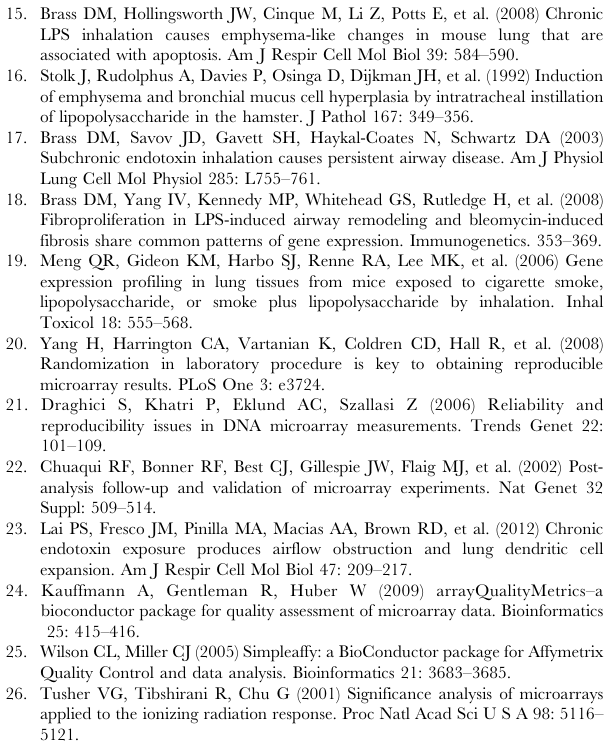
Figure S1 Overview of methods. Figure S2 Heatmap based on normalized expression intensity of 101 genes in gene signature between